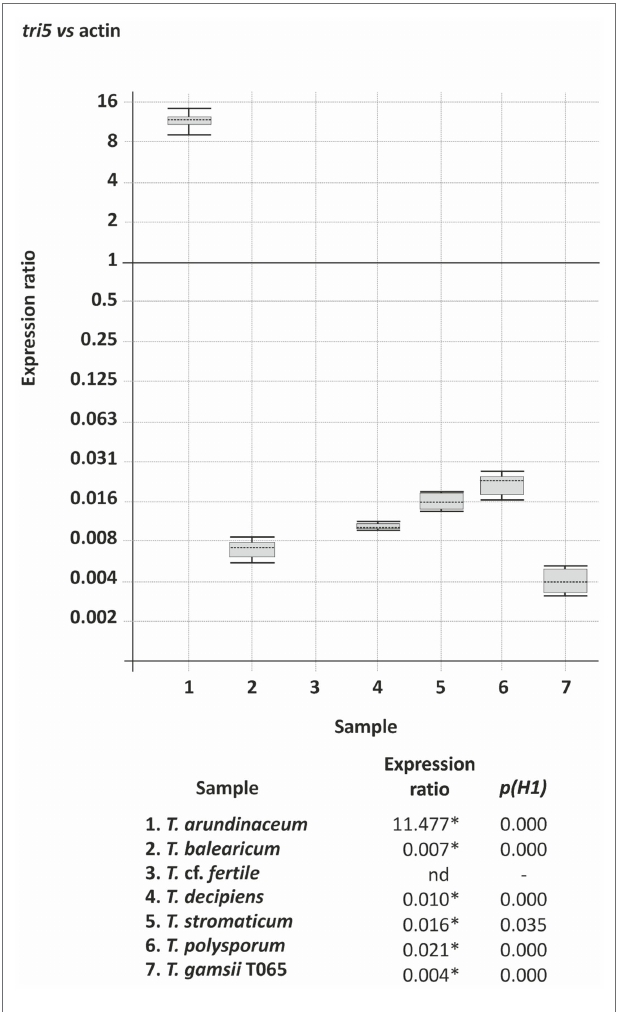
FIGURE 6 | tri5 expression in selected Trichoderma species. The data are derived from Real Time quantitative qPCR analysis and values are the level of expression of tri5 versus the actin gene. Statistically significant expression ratio values [ p(H1) < 0.05] are indicated with an asterisk. nd indicates not